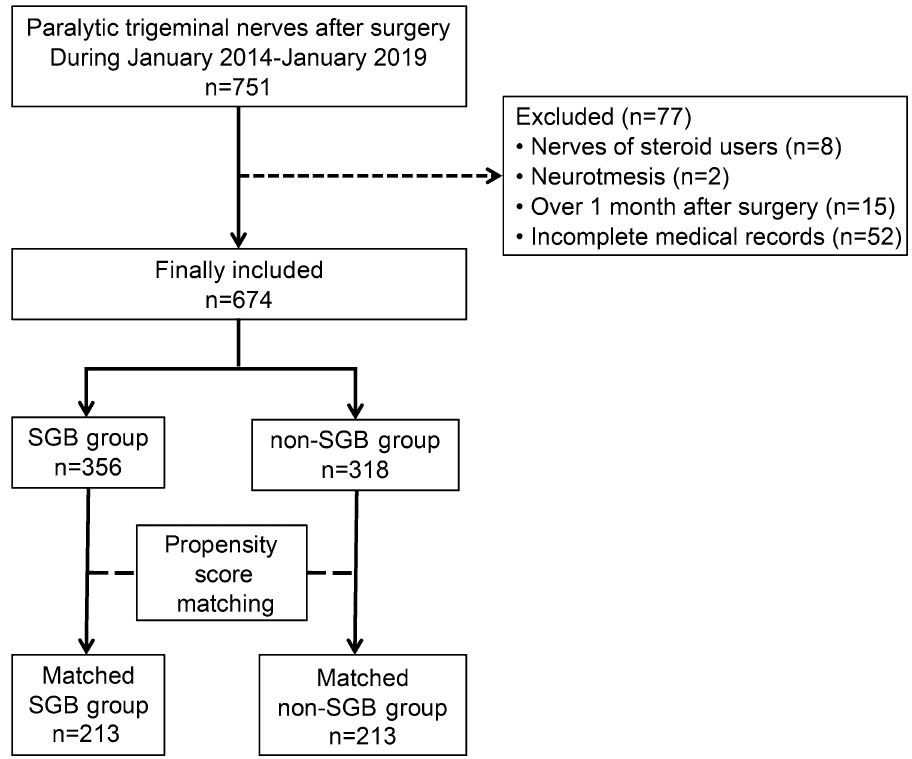
in the SGB group and 318 patients in the non-SGB group. To control for selection bias, a comparative study was performed in 426 patients using one-to-one propensity score matching (213 patients in the SGB group, 213 patients in the non-SGB group). SGB stellate ganglion